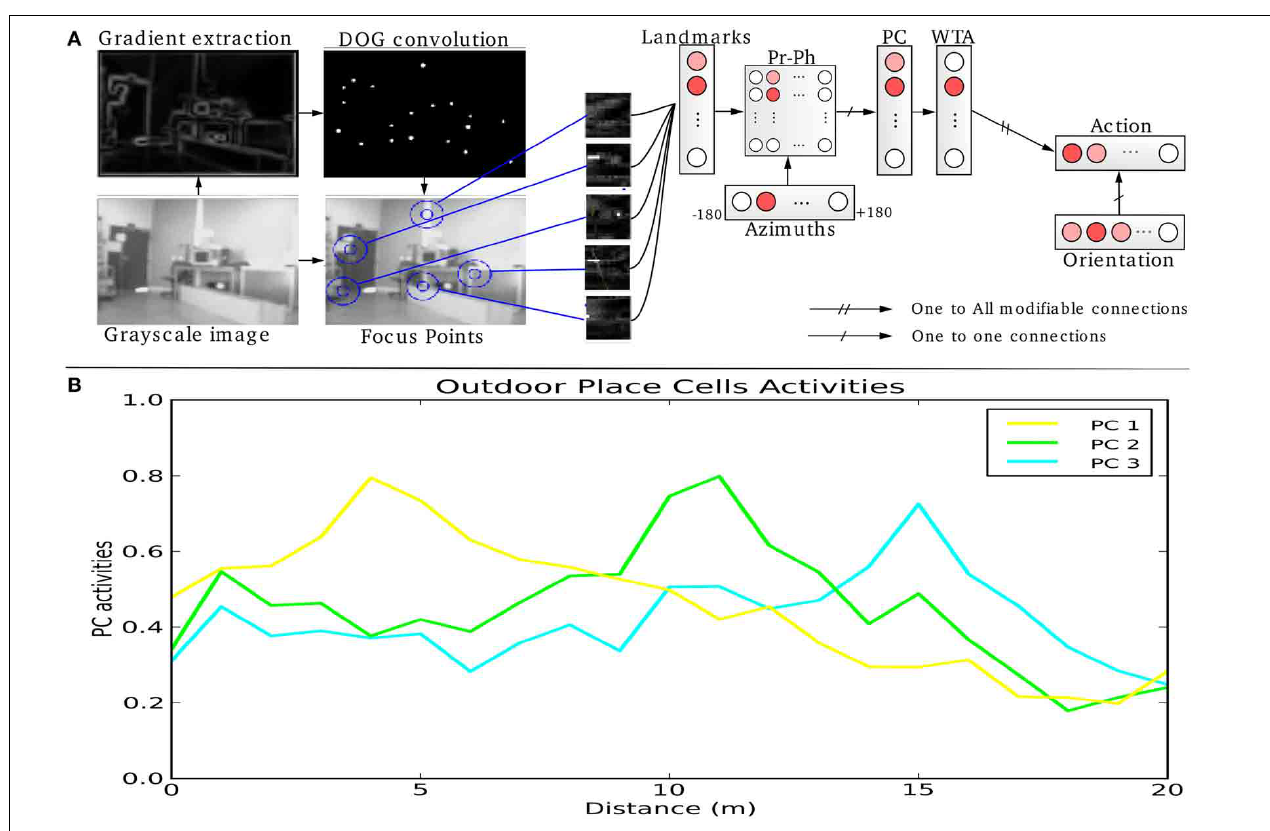
FIGURE 1 | (A) Visual Place Cells model: A pan camera picks up 15 images ( 320 × 240 pixels) over a 360 ◦ panorama. Each gradient image is convolved with a difference of gaussian filter (DoG). Local maxima of the resulting image correspond to points of interest on which the system focuses on to extract local views and their corresponding azimuths. A Visual Place Cell (VPC) learns to recognize a specific landmark-azimuth constellation from the merging of perirhinal and parahippocampal